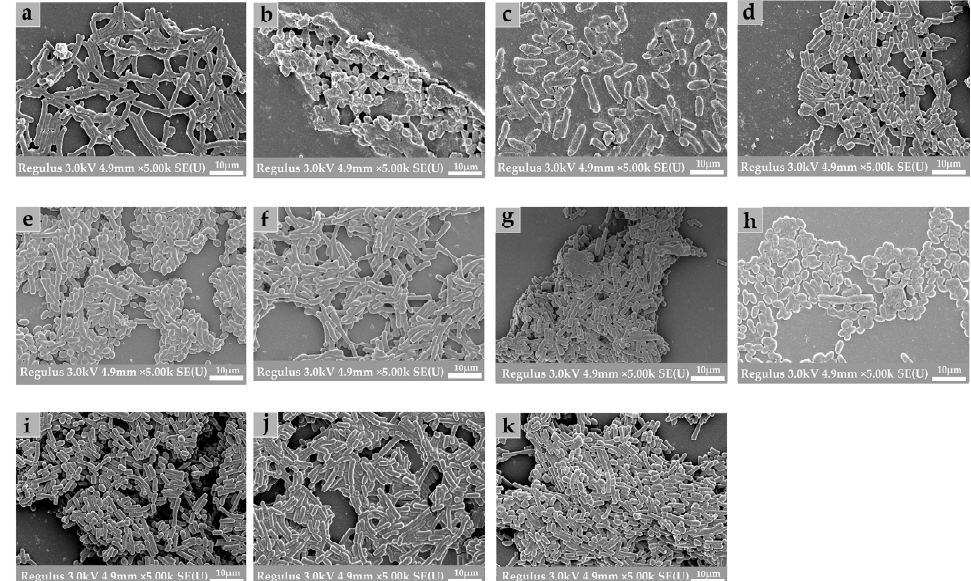
Figure 7. Field emission scanning electron microscopy (FESEM) images of mono ‐ and mixed ‐ species biofilms. All images were obtained at 5000× magnification. ( a ) B. longum ; ( b ) E. faecalis ; ( c ) B. ovatus ; ( d ) L. gasseri ; ( e ) B. longum + E. faecalis ; ( f ) B. longum + B. ovatus ; ( g ) B. longum + L. gasseri ; ( h ) E. faecalis + B. ovatus ; ( i ) E. faecalis + L. gasseri ; ( j ) B. ovatus + L. gasseri ; ( k ) B. longum + E. faecalis + B. ovatus + L. gasseri .